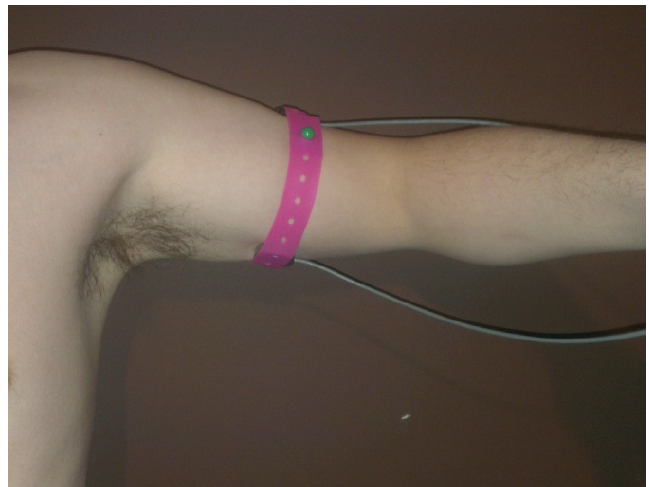
Figure 4. Bipolar electrodes position.